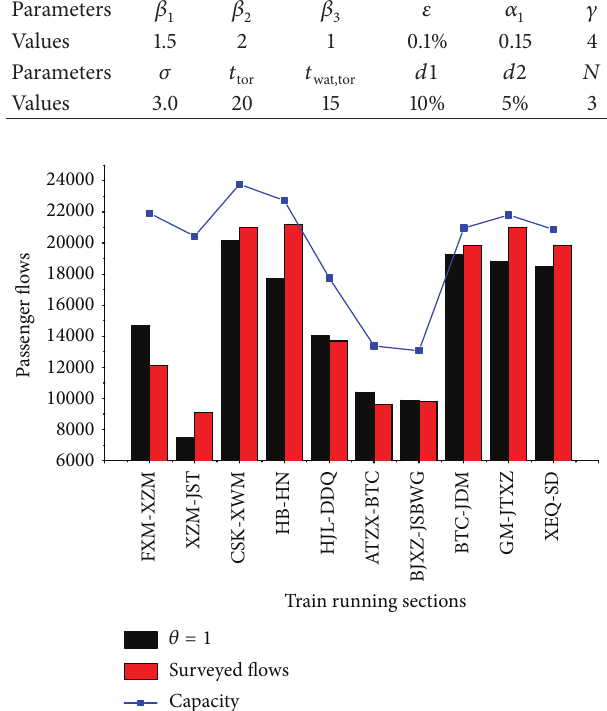
Figure 5: Comparison of surveyed flows, computed flows, and capacity in transit sections.